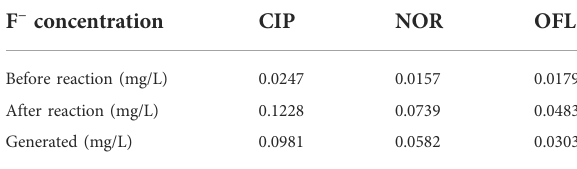
TABLE 3 The F − concentration of OFL, NOR, and CIP in the solution before and after the reaction. F − concentration Before reaction